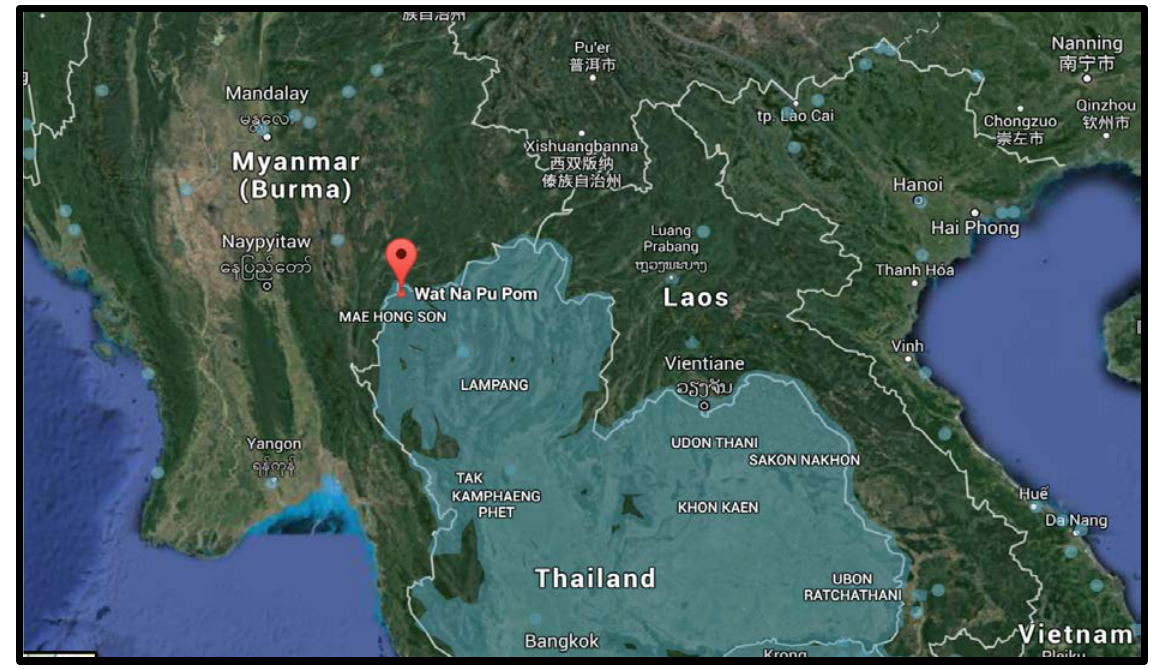
Figure 1. The study setting informed consent, the researcher ensured